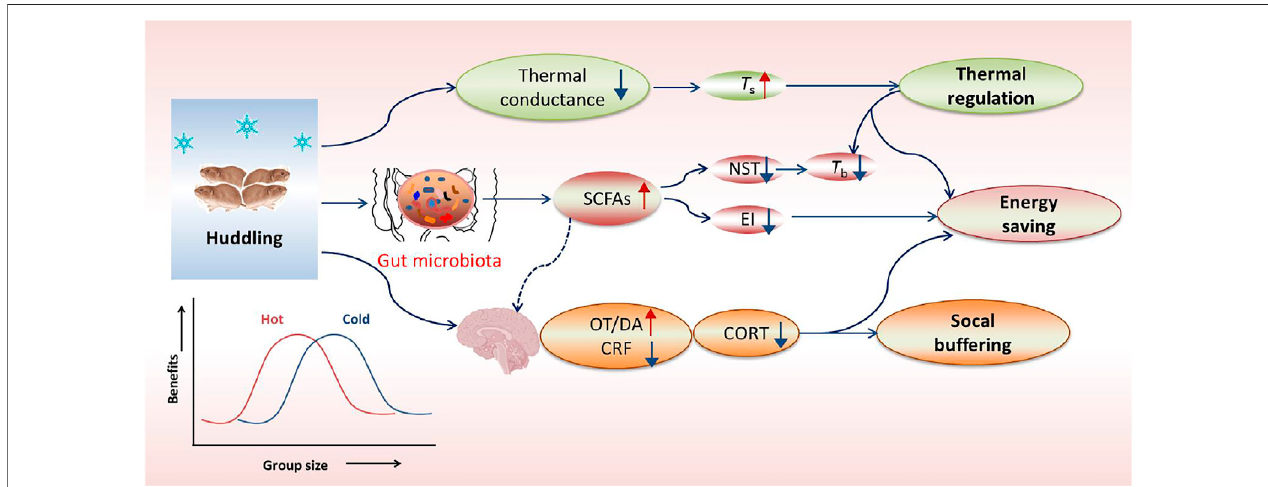
FIGURE2| Overviewofhuddling-relatedbene fi tsinthermoregulation,energysavingandsocialbuffering.Incold,thegregarious(social)rodentshuddletogetherto reduce body surface area and thus decrease thermal conductance, but can keep a relatively high body surface temperature ( T s ) and a low core body temperature ( T b ). The social environment can facilitate gut microbial community with more bene fi cial bacteria and their metabolites such as short-chain fatty acids (SCFAs), thereby inducingdecreasesinnonshiveringthermogenesis(NST)andenergyintake(EI).Additionally,socialenvironmentsparticularlysocialbondingorattachmentcanalso bufferstressresponses,whichismediatedbyincreasedneurotransmitterssuchasdopamine(DA)andoxytocin(OT),butreducedcorticotropin-releasingfactor(CRF)in the limbicsystemand hypothalamus. The energetic bene fi tofhuddling isdependent on groupsizeand ambient temperatures( T a ),and itindicates areversedU-shaped form, with an optimal group size for energy saving and other bene fi ts.